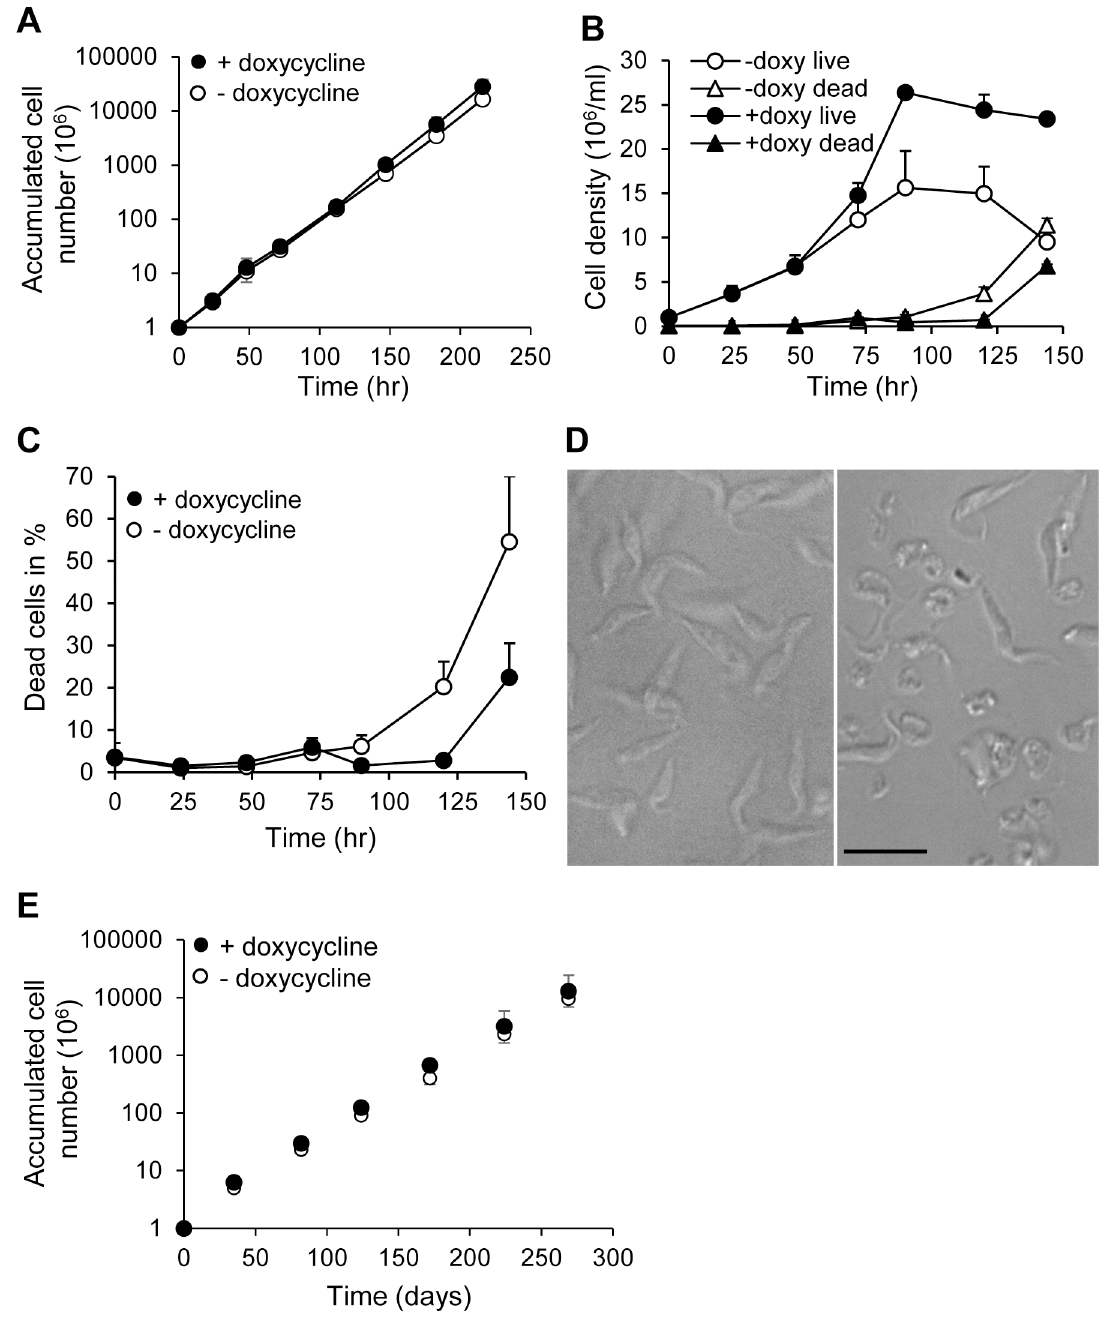
Fig 5. Tb DAT is dispensable for normal growth but is important for survival during the stationary phase. (A) Growth curves in the presence(black circles) or absence(white circles) of 1 μ M doxycycline. ( B ) Growth curves in the presence (black circles, black triangles)or absence(white circles, white triangles)of 1 μ M doxycycline. Dead cells were revealedby Zombie green staining. (C) Quantification of dead cells expressedin percentageof total cells as a function of time. (D) DIC of two days stationary phaseof growth cells grown in the presence (left panel)or absence(right panel)of doxycycline. The scale bar represents 10 μ m. (E) Growth curve of Δ tbdat/ Δ tbdat/TetO : V5 : TbDAT grown in the presence (black circles) or absence(white circles) of doxycycline in delipidatedmedium. ( A )( B )( C )( E ) Growth curves were performed at least twice in duplicateand standarddeviationsare shown.